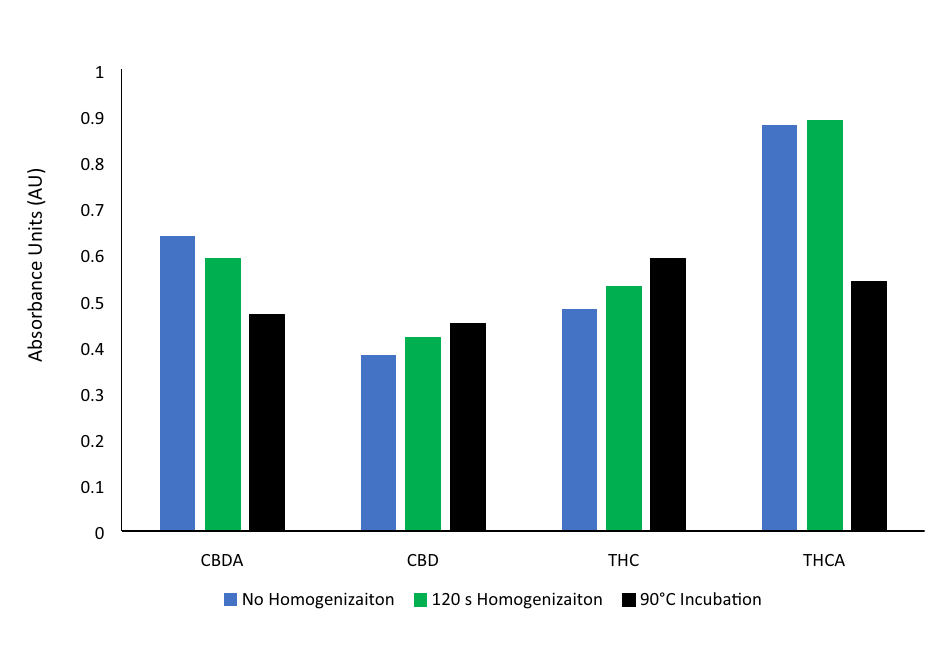
Fig. 2 CBD, CBDA, THC and THCA structure. Acid forms (CBDA and THCA) are decar- boxylated to neutral forms when exposed to temperatures in excess of 90 °C, altering the cannabinoid profile of the processed